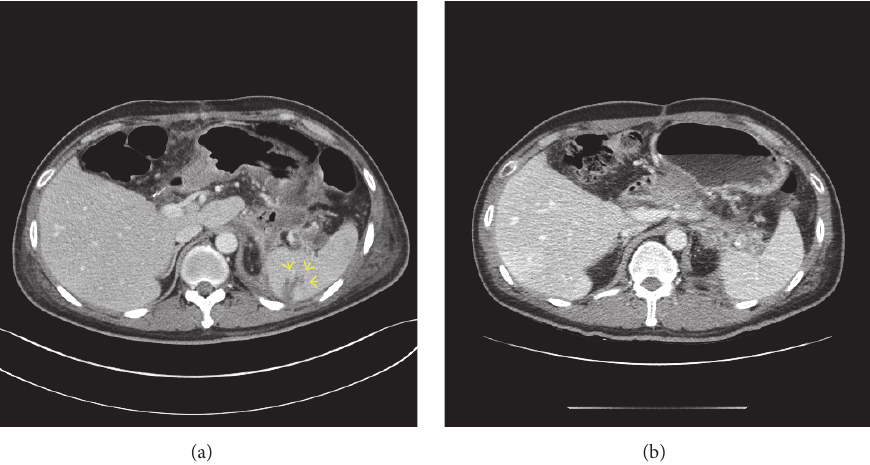
Figure 4: (a) CT scan on 2 days following the SAE. A small area of splenic infarction was seen. (b) CT scan on 4 months following the SAE. The infarcted area was not observed any